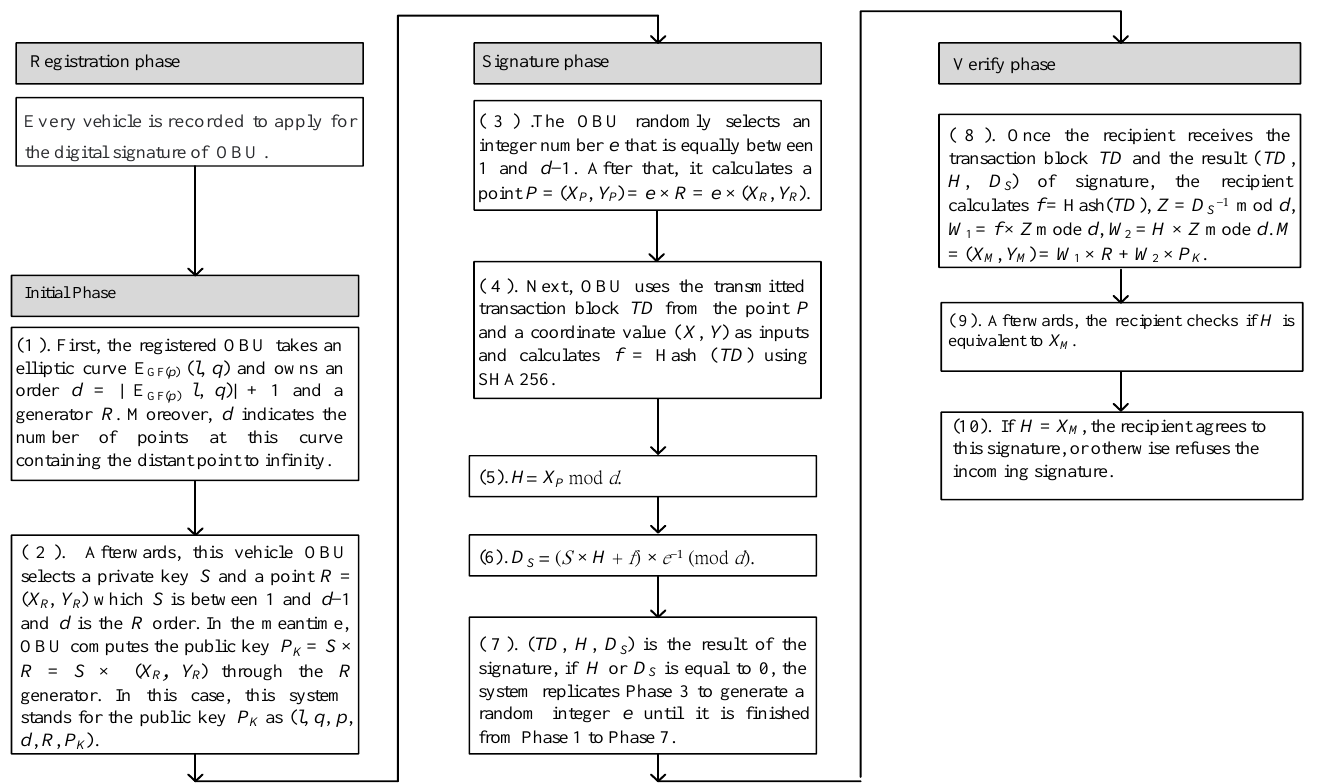
Figure 2. The procedure of the ECDSA digital signature on the transaction block.